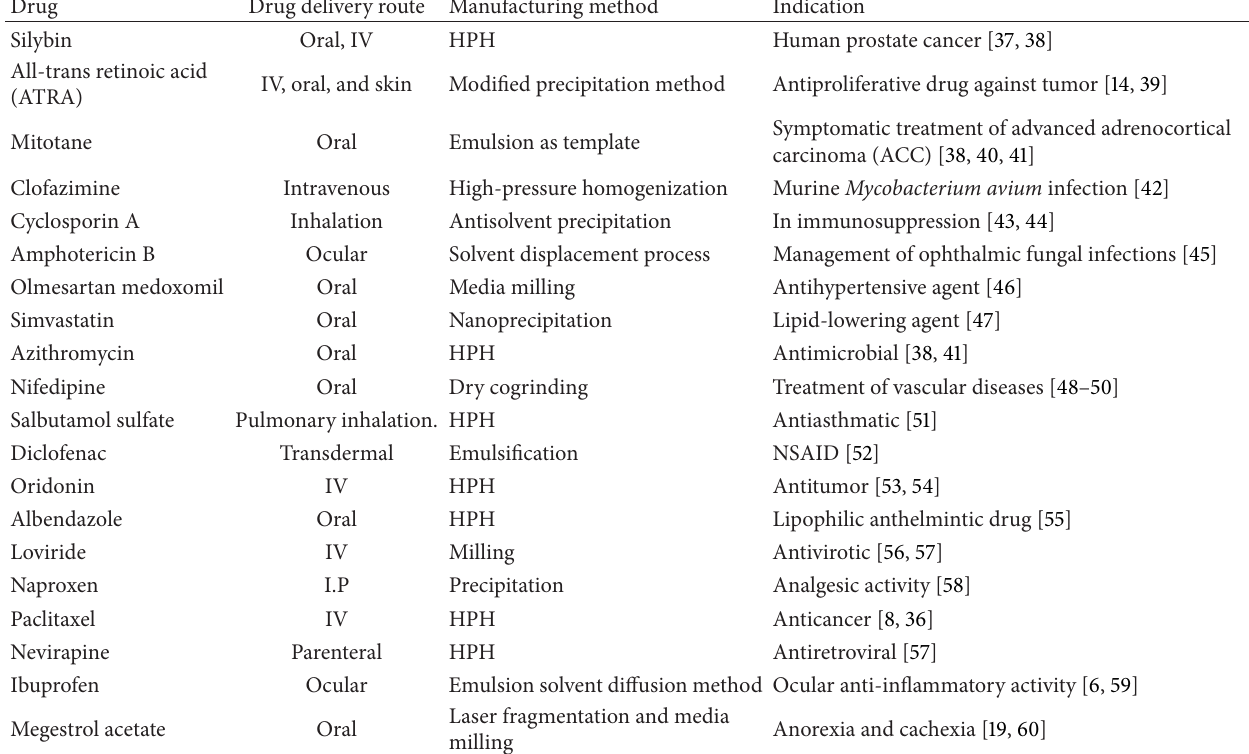
Table 2: Summary of drug